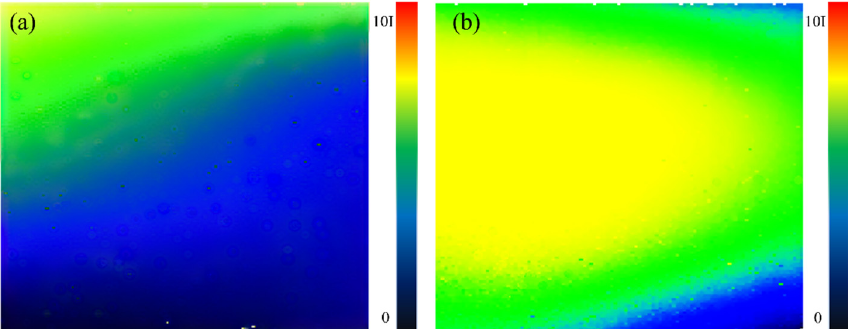
Figure 12. Radial radiation intensity distribution cloud diagram of sandwich transducer: ( a ) vibration intensity cloud diagram of transducer shaft side first order natural frequency; ( b ) Vibration intensity cloud diagram of transducer shaft side under second order natural frequency.